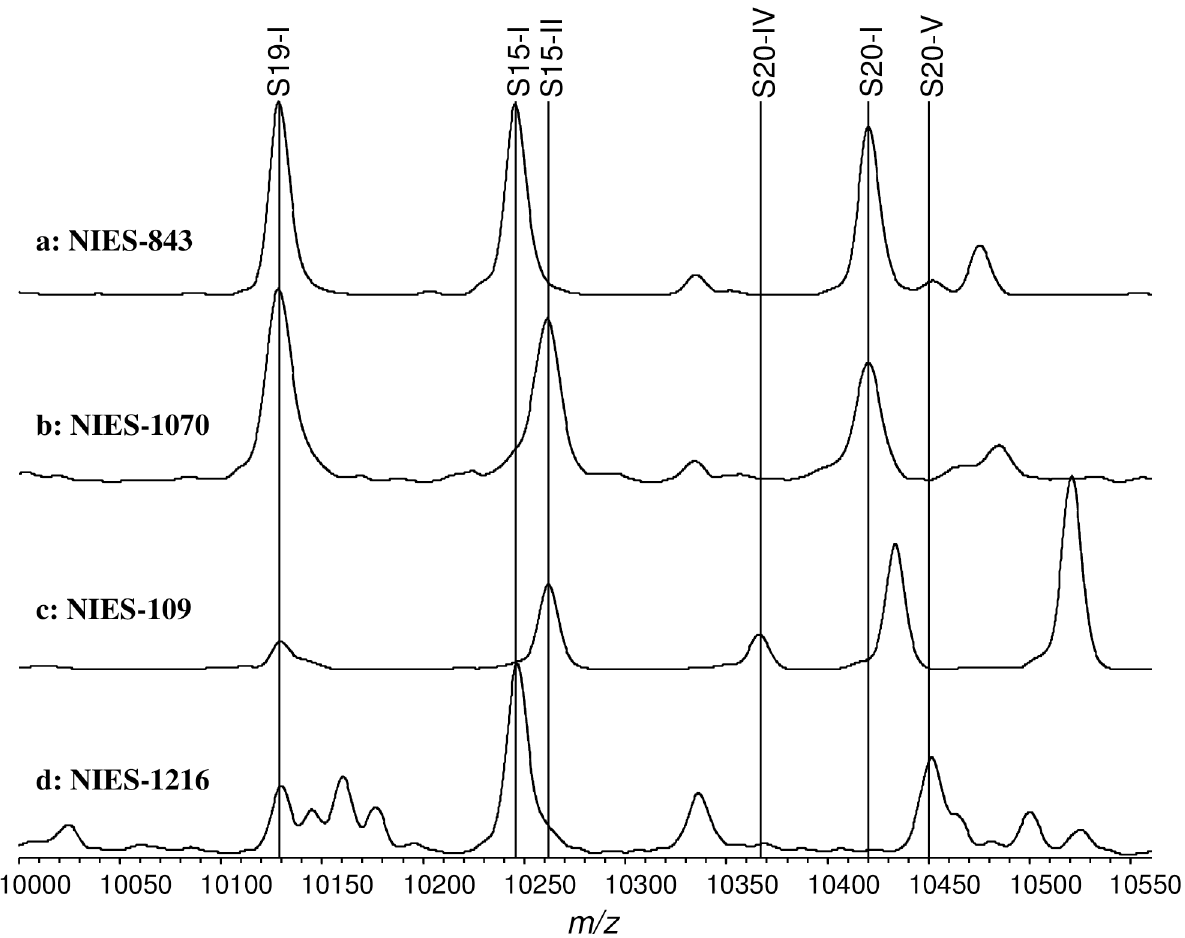
Fig 3. Expanded view of ribosomal proteins S19, S15, and S20 ( m/z 10000 – 10500) from four strains. a: NIES 843; b: NIES 1070; c: NIES 109; d: NIES 1216. S19, S15, and S20 types are indicated by name.